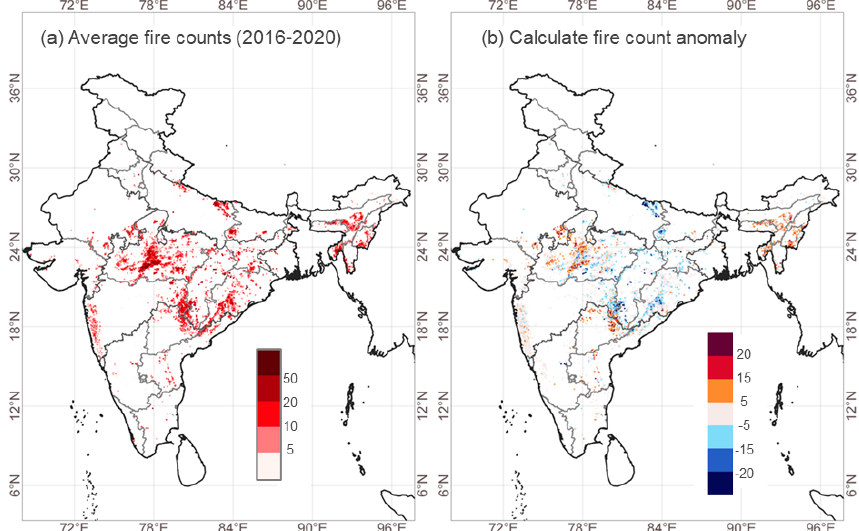
Figure 2. Spatial distribution of the 5km × 5km gridded VIIRS fire counts. (a) Average fire counts during the analysis period (25 March– 3 May 2016–2020). (b) Gridded fire anomaly during the lockdown in